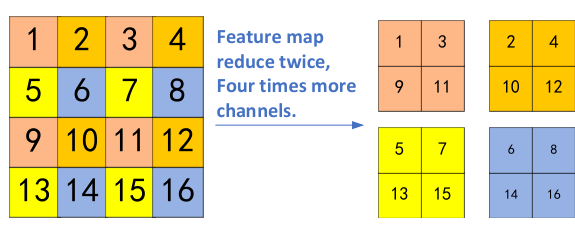
Figure 3 The Passthrough layer